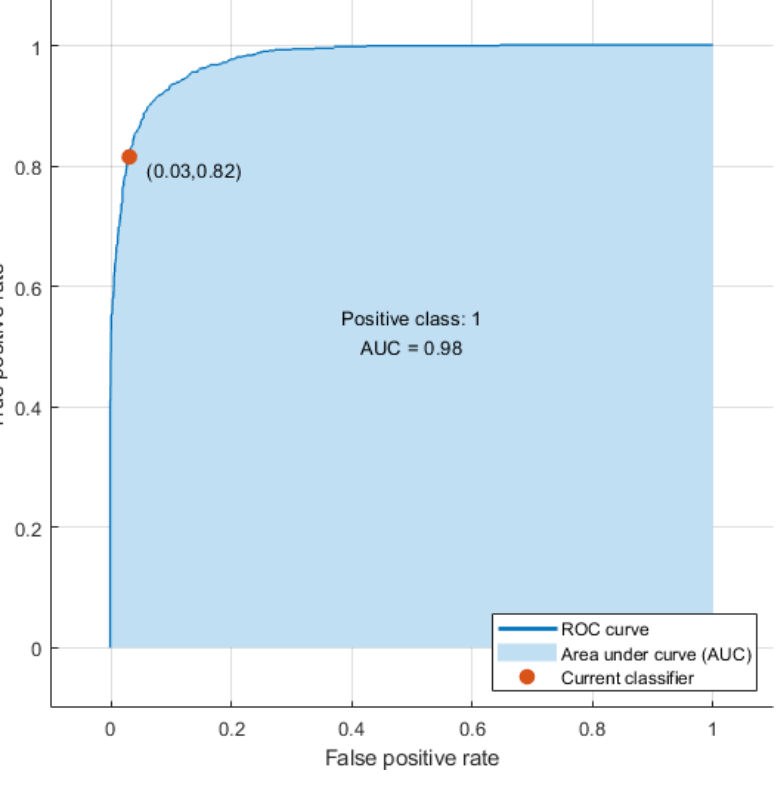
Figure 6. ROC: class 1